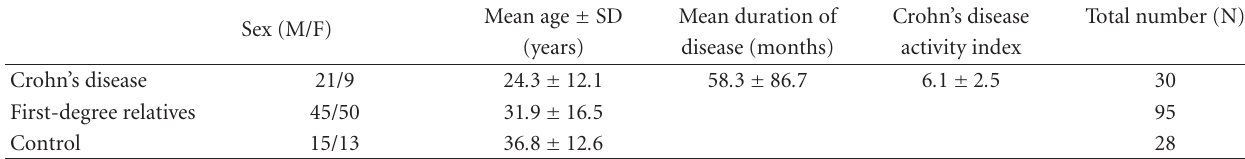
Table 1: Demographic and clinical data of Crohn’s disease, first-degree relatives, and